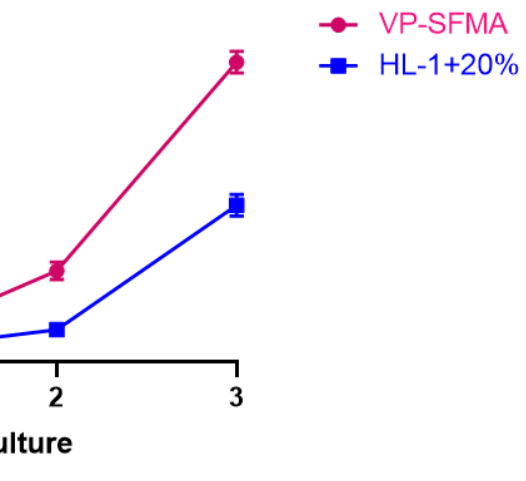
Figure 4. Comparison of growth curve of B. duncani proliferation using VP-SFMA with HL-1 + 20% FBS medium. Values represent the mean from three separate experiments using triplicate wells for each test condition. PPE: percentage of parasitized